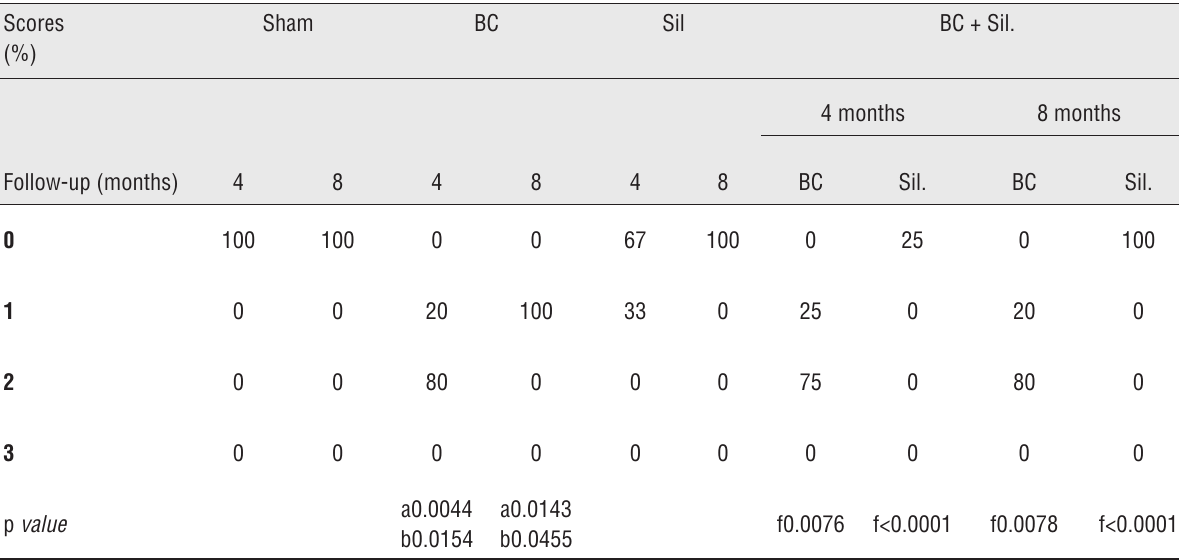
Supplementary Table 1 - The intensity of the inflammatory